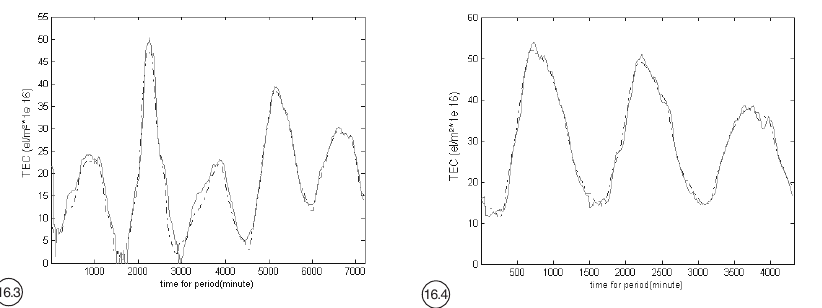
Fig. 16.3. Observed GPS-TEC results for disturbed solar-terrestrial conditions (dotted), and 1 h ahead Forecast (solid) TEC values for the enlarged portion of the time of validation period: 18-22 April 2002. Fig. 16.4. Observed GPS-TEC results for quiet solar-terrestrial conditions (dotted), and 1 h ahead Forecast (sol- id) TEC values for the enlarged portion of the time of validation period: 5-7 April 2002.